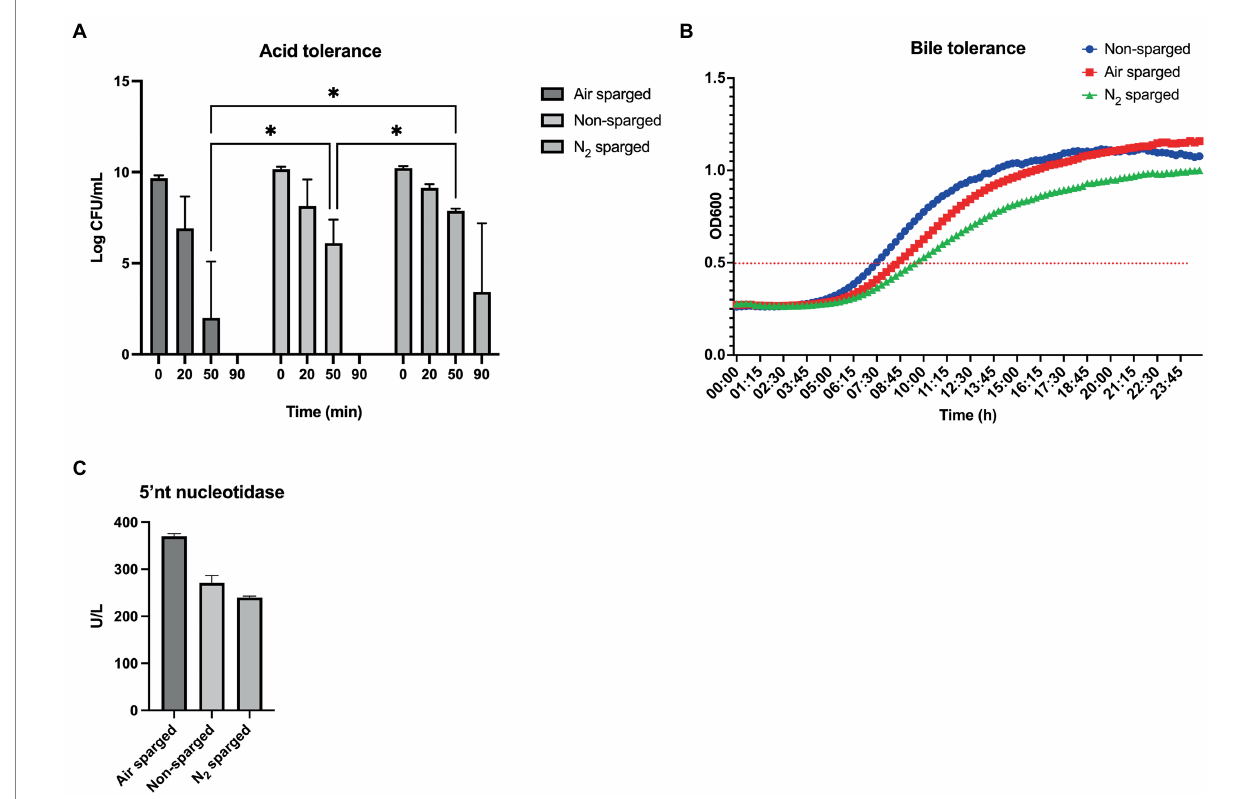
FIGURE 5 Probiotic functionality markers in FD products prepared for the three culture conditions. (A) Acid tolerance, (B) Bile tolerance and (C) 5 ′ nucleotidase (NT) activity. Statistical significance was calculated using two-way ANOVA for the bile tolerance and Friedman test with Dunn’s multiple comparisons test for the 5 ′ NT activity. * indicates value of p < 0.05; ns, not significant. Data are mean ± SD of two biological replicates for three